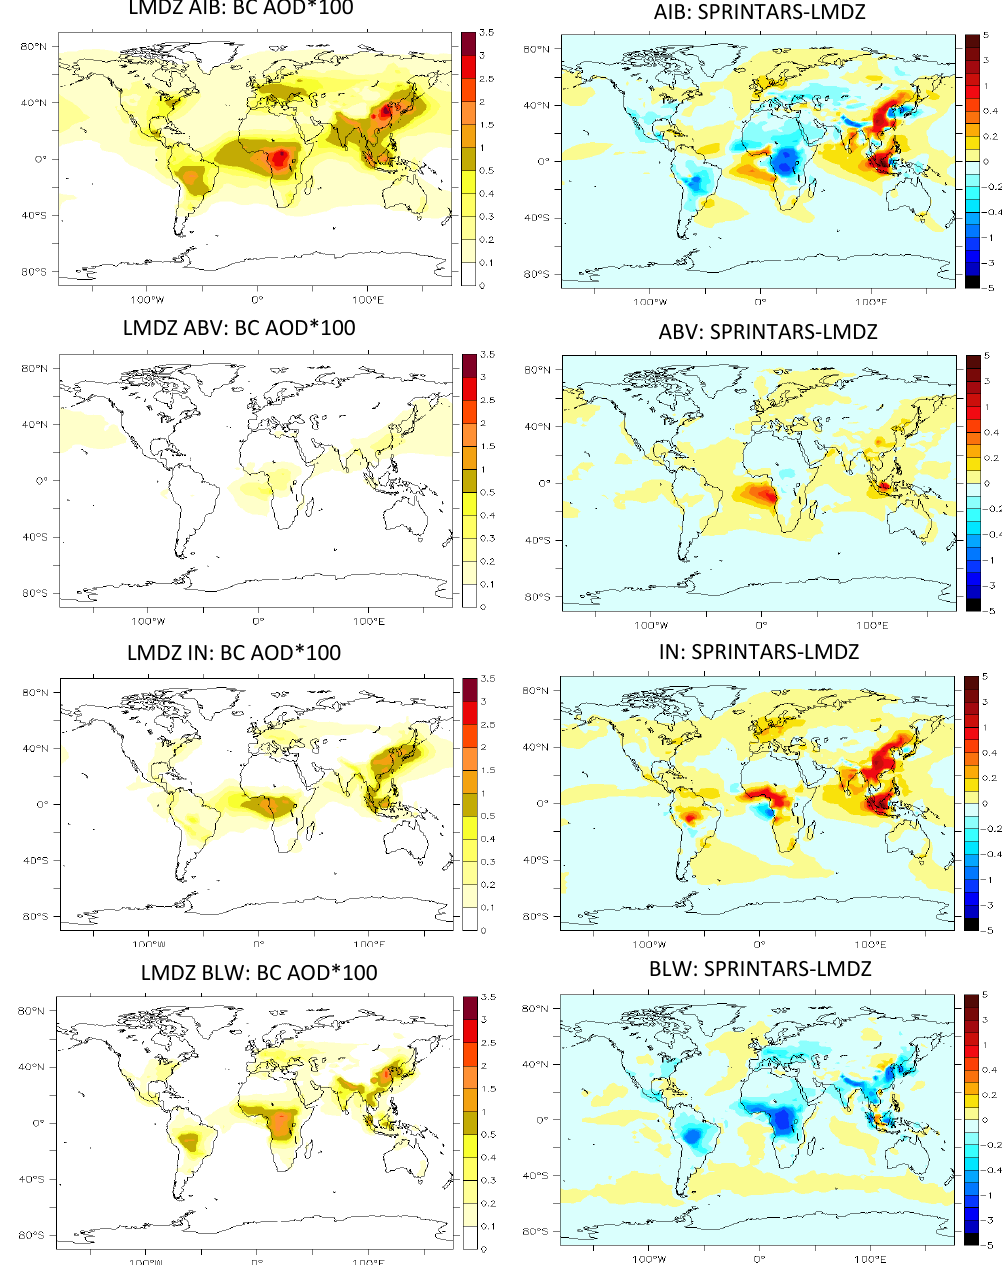
Fig. 4. Left column: reading LMDz values of BC optical depth (BC AOD). Right column: reading SPRINTARS minus reading LMDz values of BC AOD. Top to bottom: AIB, ABV, IN and BLW